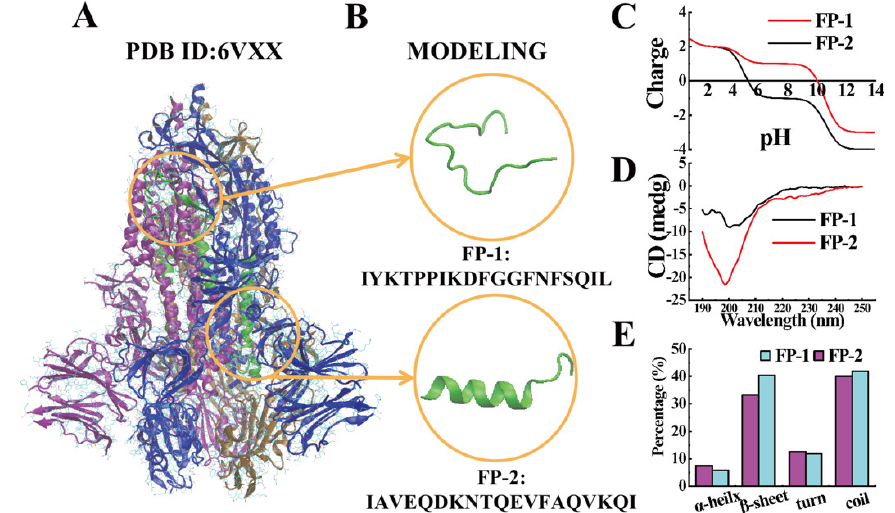
Figure 1. ( A ) Cryon-EM structure of SARS-CoV-2 S protein (PDB: 6VXX) [32] with the highlighted functional peptides (green). Each monomer is drawn in a different color (purple, blue, tan). ( B ) The SARS-CoV-2 functional-peptide structures were modeled using SARS-CoV-2 S protein. FP-1 adopts random-coil secondary conformation, and FP-2 adopts α-helical secondary conformation. ( C ) The plot of charge vs. pH of FP-1 and FP-2; ISO, isoelectric point. ( D ) CD of the secondary structure of FP-1 and FP-2 (66 μM) in solution. ( E ) The contents of secondary structures of FP-1 and FP-2 (66 μM).